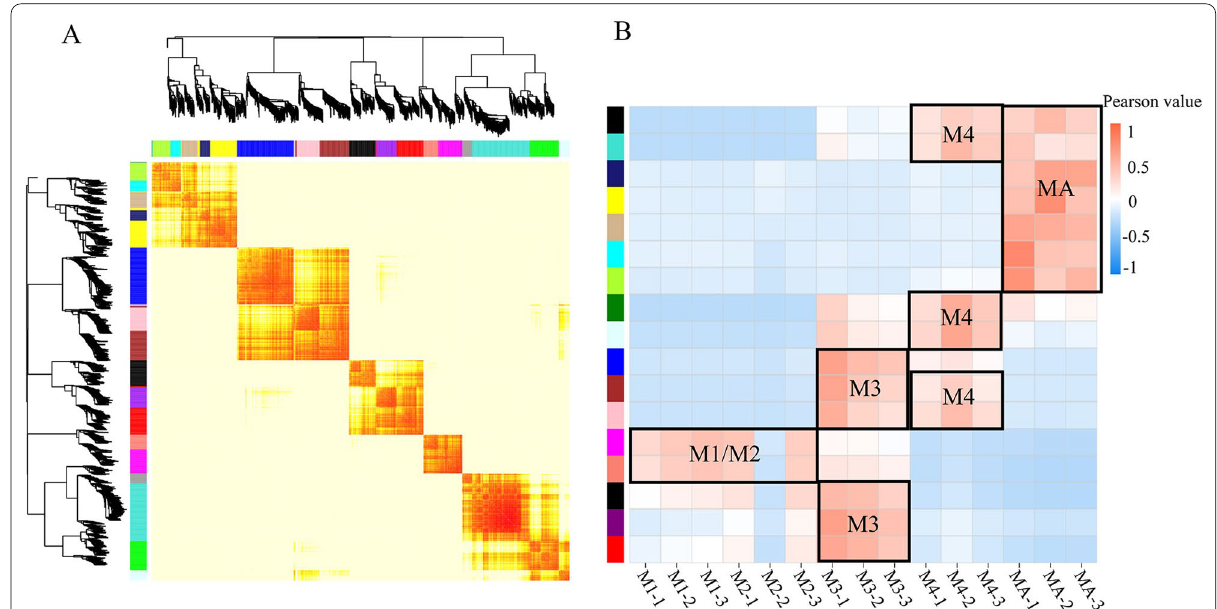
Fig. 9 Network analysis dendrogram showing co-expression modules identified by weighted gene co-expression network analysis (WGCNA) of differentially expressed genes (DEGS). ( A ) Dendrogram plot with color annotation. The genes in the same branch could be assigned to different modules. ( B ) Heatmap plot of module-trait relationships. Red represents high adjacency (positive correlation) and blue represents low adjacency (negative correlation). The color scale on the right shows module-trait correlation from -1 (blue) to 1 (red)